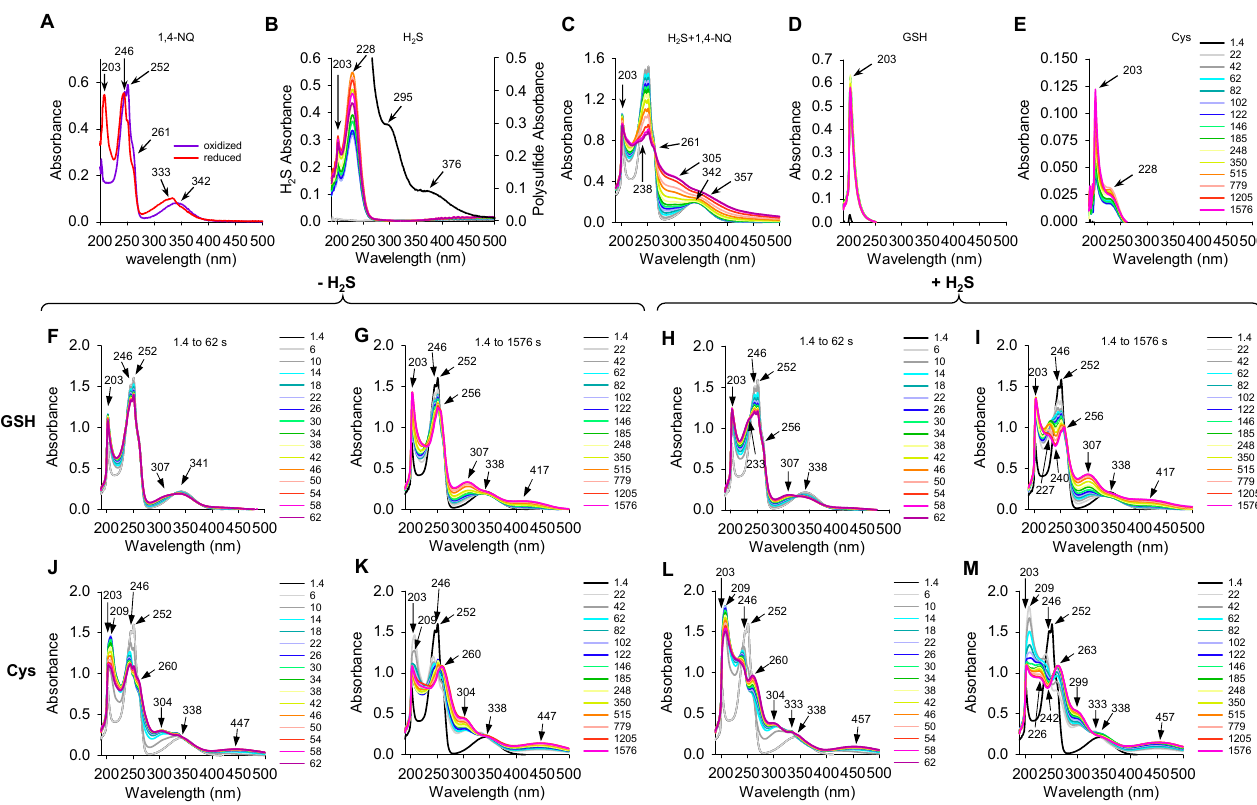
Figure 2. Absorption spectra of 1,4-NQ and reactions with thiols. ( A – D ) Reference spectra of oxidized and N 2 -reduced 1,4-NQ ( A ), 60 µ M H 2 S and polysulfides ( B ), 60 µ M H 2 S plus 60 µ M 1,4-NQ ( C ), GSH ( D ), and Cys ( E ). Time-resolved absorption spectra of 1,4-NQ (60 µ M) and GSH (60 µ M; ( F – I )) or Cys (60 µ M; ( J – M )) without (-H 2 S; ( F , G , J , K )) or with ( H , I , L , M ) 60 µ M H 2 S. ( F , H , J , L ) show responses over the initial 62 s and ( G , I , K , M ) show responses over 1576 s. Time key at the right indicates elapsed time in seconds and arrows show wavelengths of major